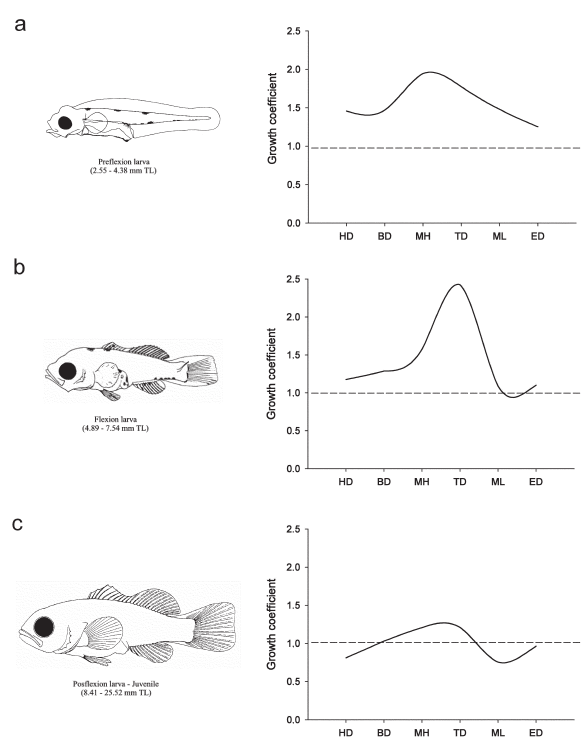
F IG . 4. – Growth coefficients of body proportions during spotted sand bass development. Each graph represents the growth coeffi- cients during a total length interval. BD, body depth; ED, eye diam- eter; HD, head depth; MH, musculature height; ML, mouth length; TD, tail